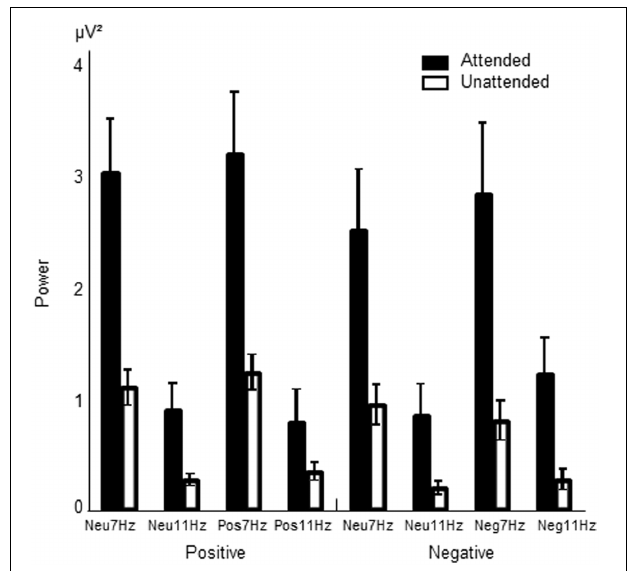
FIGURE 2 | Mean power values of the ssVEP and their respective standard errors of the mean (s.e.m) illustrating the attention effect. Black bars show power values at the labeled frequency (7 or 11Hz) when attended; white bars show power when unattended. Illustrated are the neutral and emotion conditions of the positive and negative